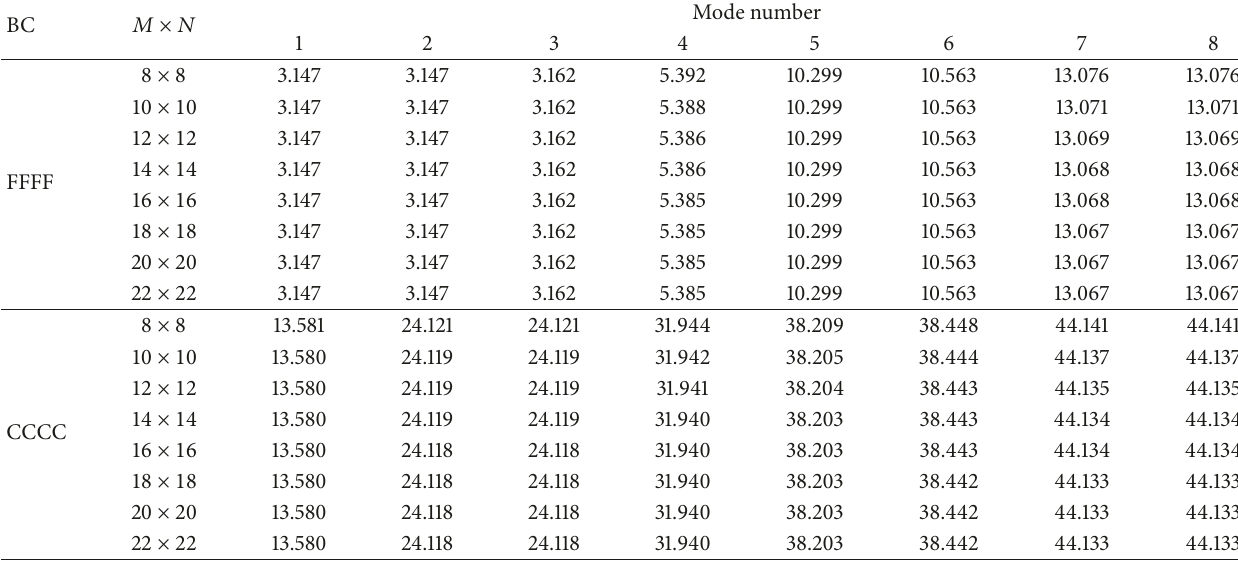
Table 1: Convergence of frequency parameter Ω for angle-ply (0/90 ∘ ) rectangular laminate plates with free and CCCC boundary constraints (Material I) .